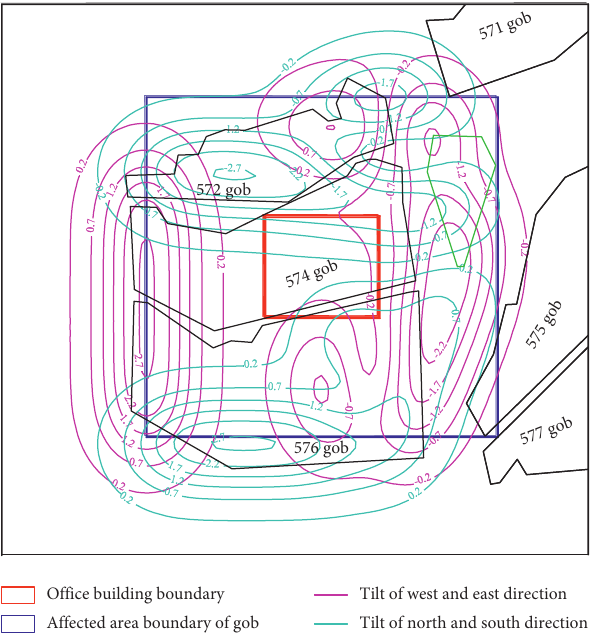
Figure 20: Contour map of the tilt of gobs below the office building (unit